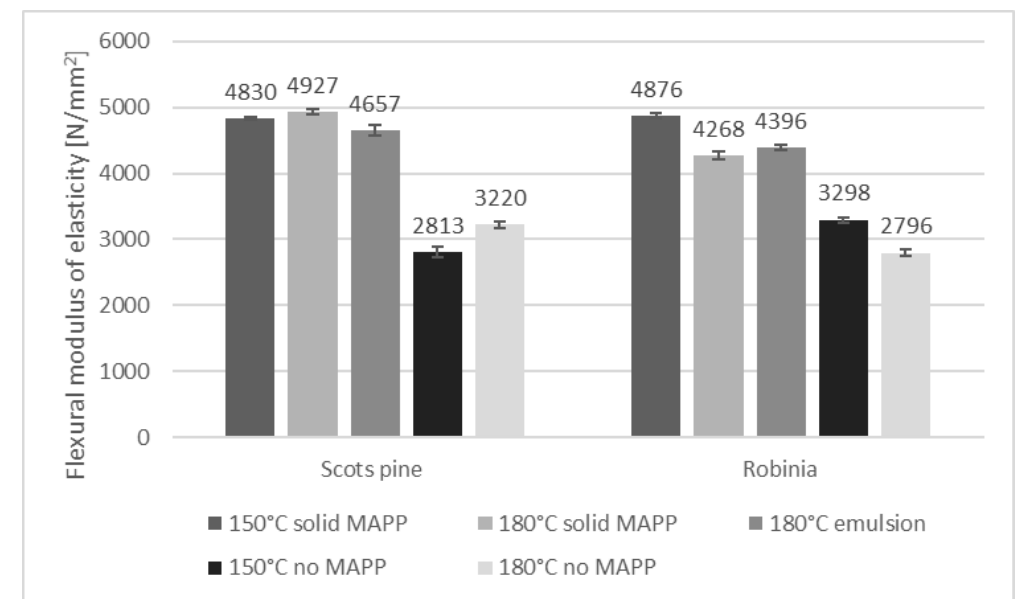
Figure 2. Flexural modulus of elasticity (MOE) of composites with TMP based on Scots pine or Robinia. For comparison, flexural MOE of composites with wood flour (softwood) was 6202 N/mm 2 including MAPP (solid) and 4047 N/mm 2 excluding MAPP.